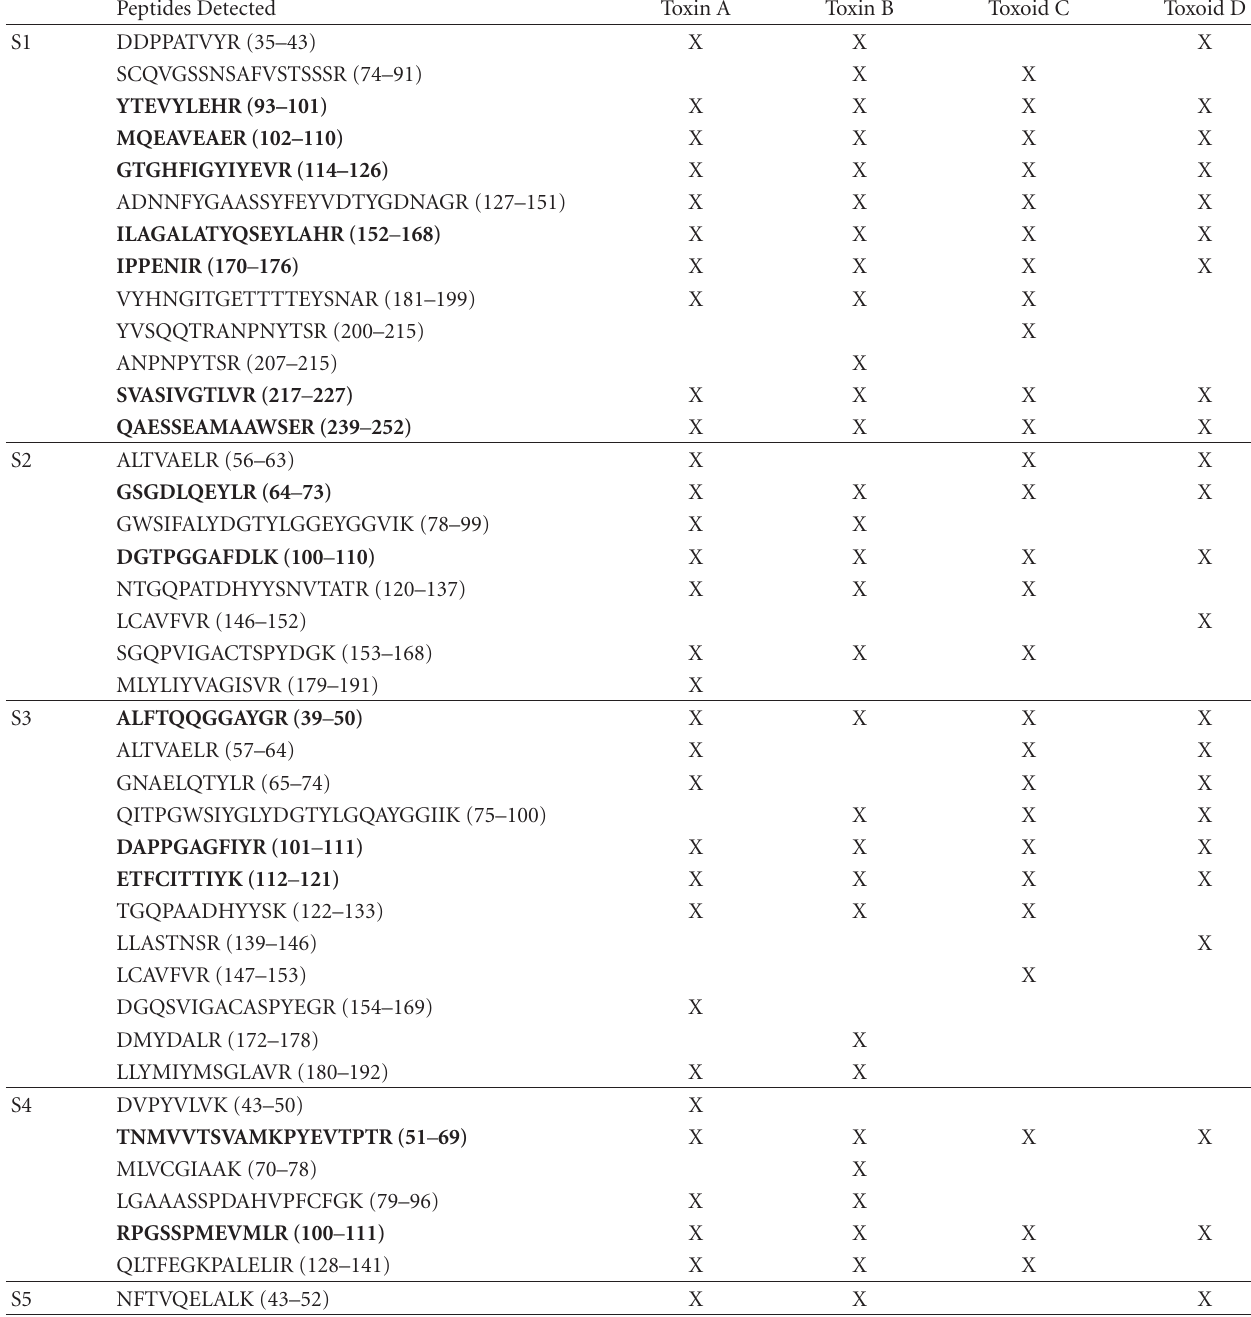
Table 2: Mass spectrometry-detected peptides found among all pertussis toxins and toxoids. Peptides Detected Toxin